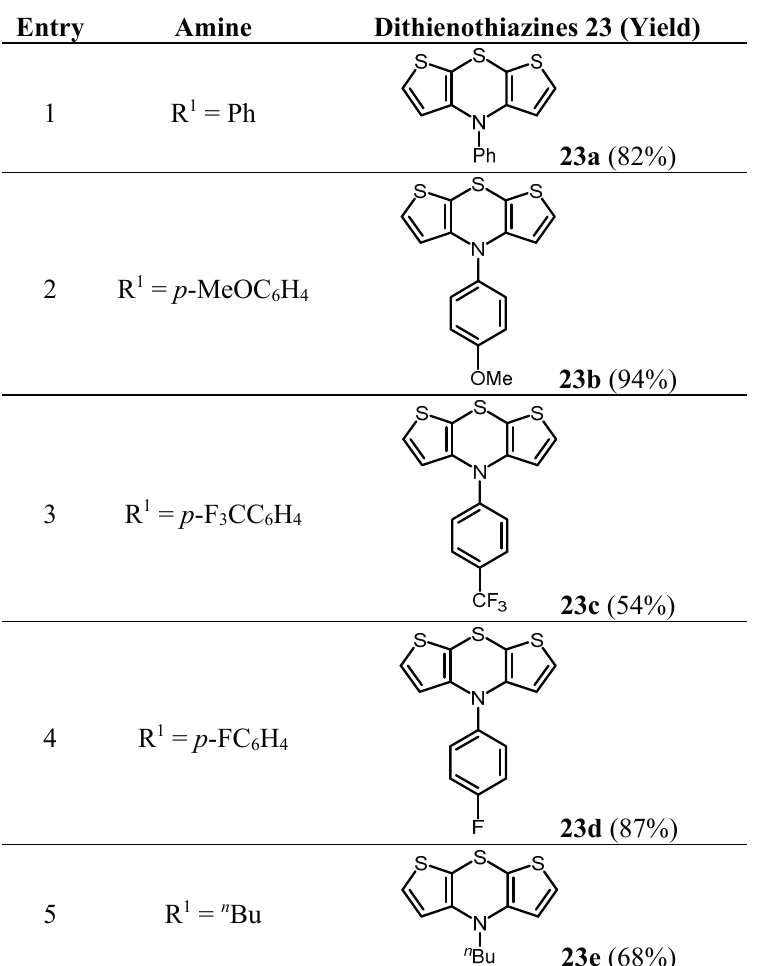
Table 6. Selected dithienothiazines 23 via Pd-catalyzed intermolecular intramolecular Buchwald-Hartwig double